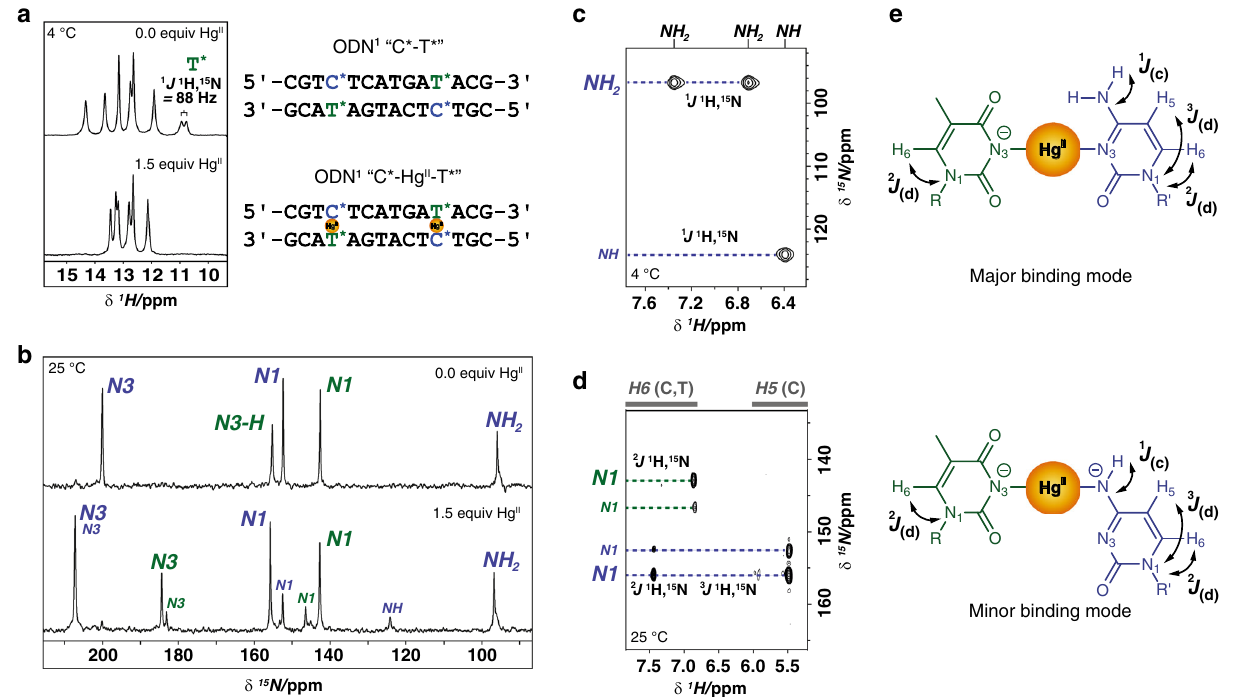
Fig. 3 1 H and 15 N NMR spectra of duplex DNA upon formation of C-Hg II -T base pairs. a Imino proton region of 1 H NMR spectra of ODN 1 * “ C*-T* ” in the absence and presence of 1.5 equiv of Hg II (where blue C* = 15 N-labelled C, and green T* = 15 N-labelled T). b 15 N NMR spectra of ODN 1 * “ C*-T* ” before and after adding Hg II . c 1 J 1 H, 15 N coupling of cytosine (N4)NH 2 major and of cytosine (N4)NH minor according to [ 15 N, 1 H]-HSQC. For full spectrum see Supplementary Fig. 9b. d Assignment of N1 major and N1 minor of thymidine and cytosine by 3 J - and 2 J -coupling between N1 and H5 and/or H6 in the long- range [ 15 N, 1 H]-HSQC spectrum. For full spectra see Supplementary Fig. 10a. e Major- and minor coordination modes of Hg II bound to C-T mismatches. DNA samples contained 1.0 mM b or 0.5 mM a , c , and d of duplex DNA and 1.5 equiv of Hg II (relative to the mismatches present) in aqueous